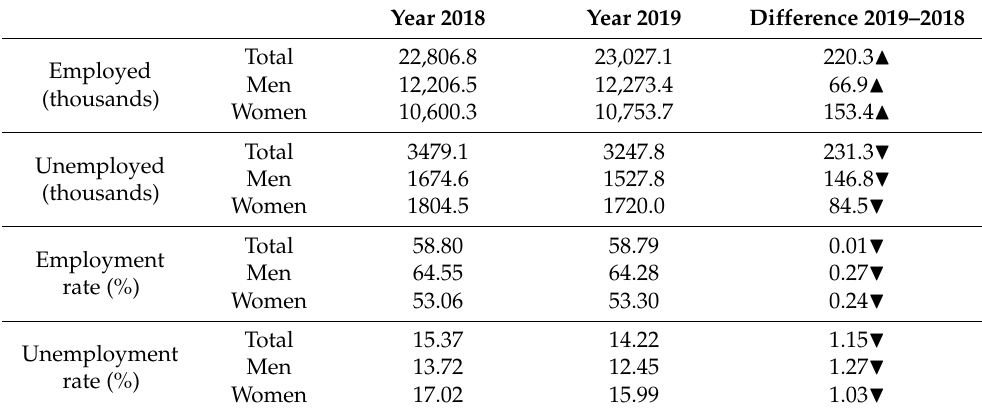
Table 1. Comparison by sex of the main variables of the Spanish labor